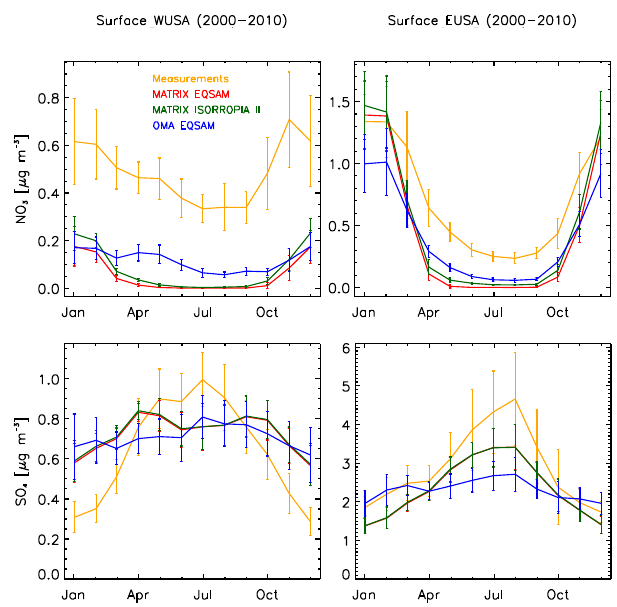
Figure 6. The 2000–2010 mean annual cycle over WUSA (left) and EUSA (right), error bars represent ± 1 standard deviation. Mea- surements are in orange, MATRIX-EQSAM is in red, MATRIX- ISORROPIA II is in green, and OMA-EQSAM is in